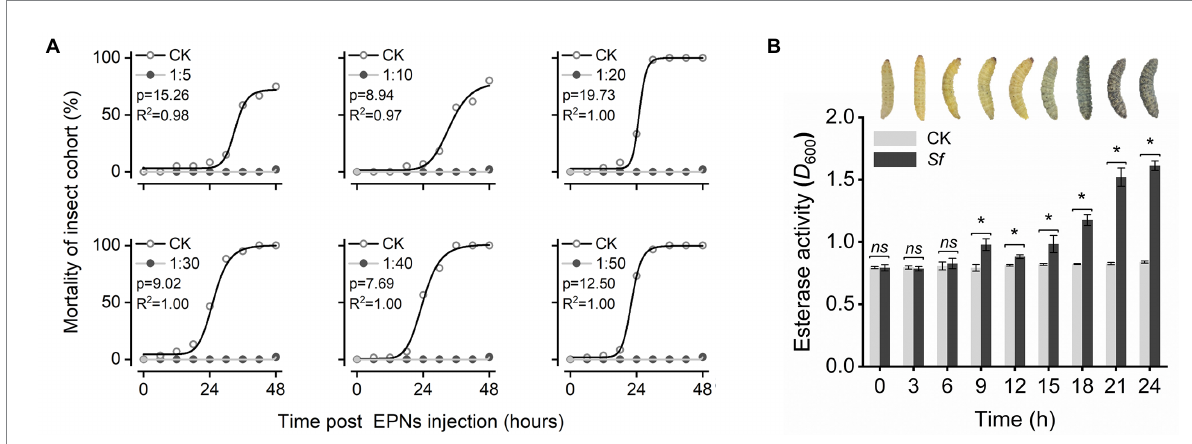
FIGURE 1 Changes in G. mellonella after nematode injection: (A) Insecticidal activity of S. feltiae injected with different densities against G. mellonella . Analysis using the logistic function (y = A2 + (A1 − A2)/(1 + (x/x0)^p)) in nonlinear fitting. (B) Apparent changes in the phenotype and esterase activity of G. mellonella . After exposure of 20 IJs to the body